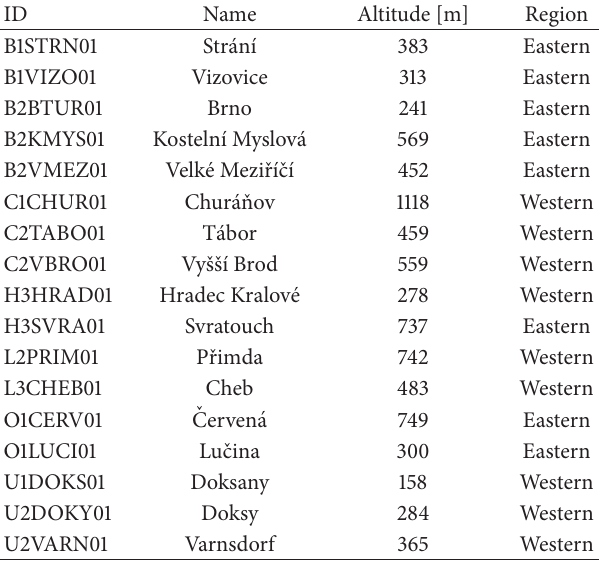
Table 1: Overview of the stations used for